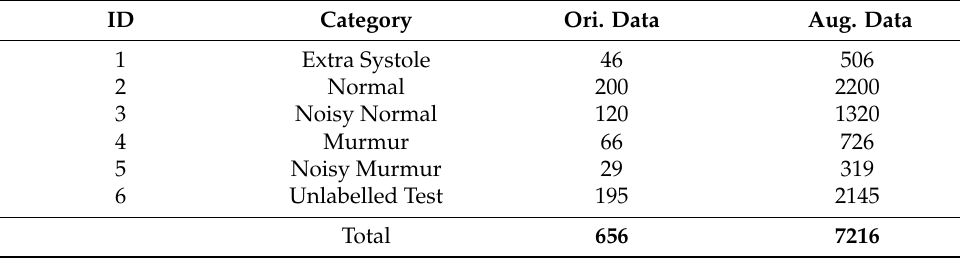
Table 6. Heart Sound Dataset: Original and Augmented